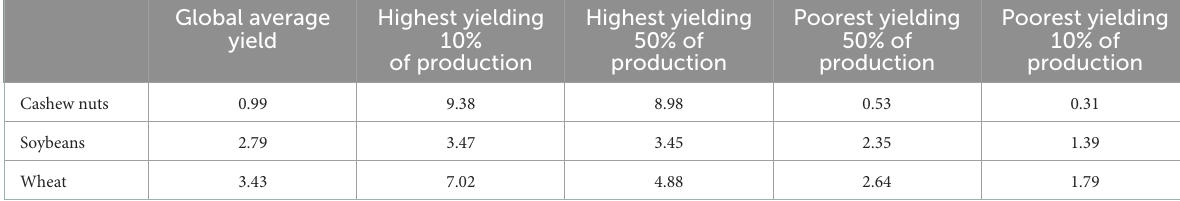
TABLE 1 Yield characteristics (tons per hectare) of selected global crop production in 2018, calculated using data from FAO (2021). Global average Highest yielding Highest yielding Poorest yielding Poorest yielding yield 10% 50% of 50% of 10% of production production production